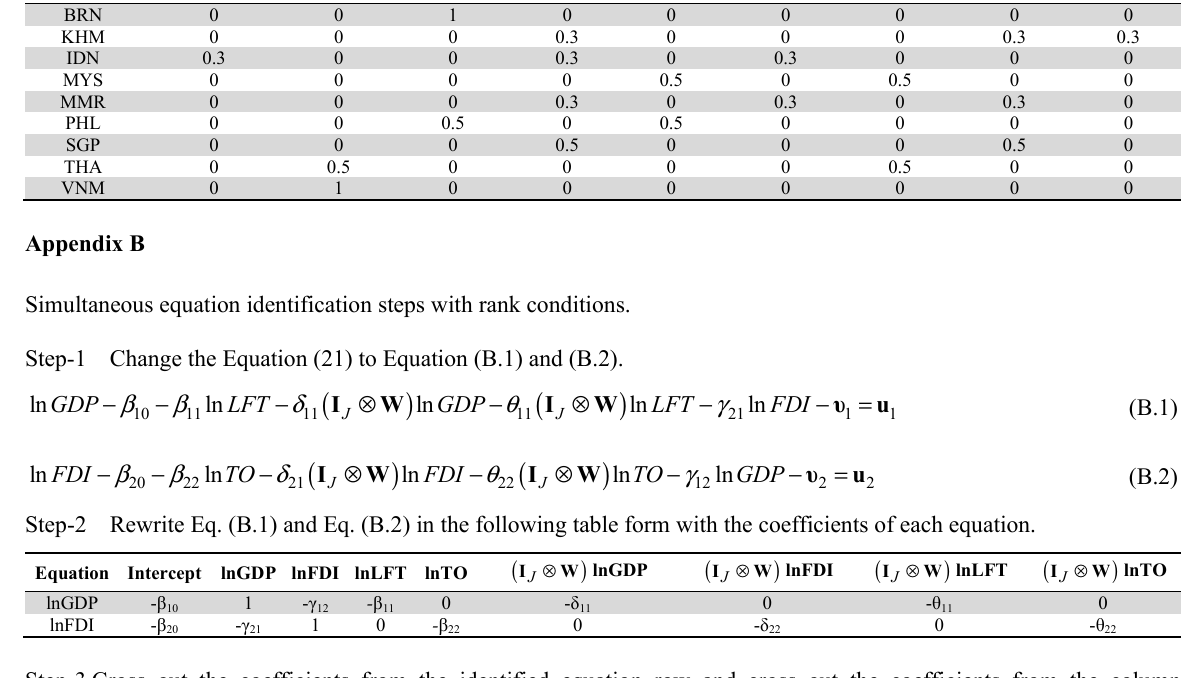
Step-3 Cross out the coefficients from the identified equation row and cross out the coefficients from the column corresponding to the identified equation coefficient and not equal to